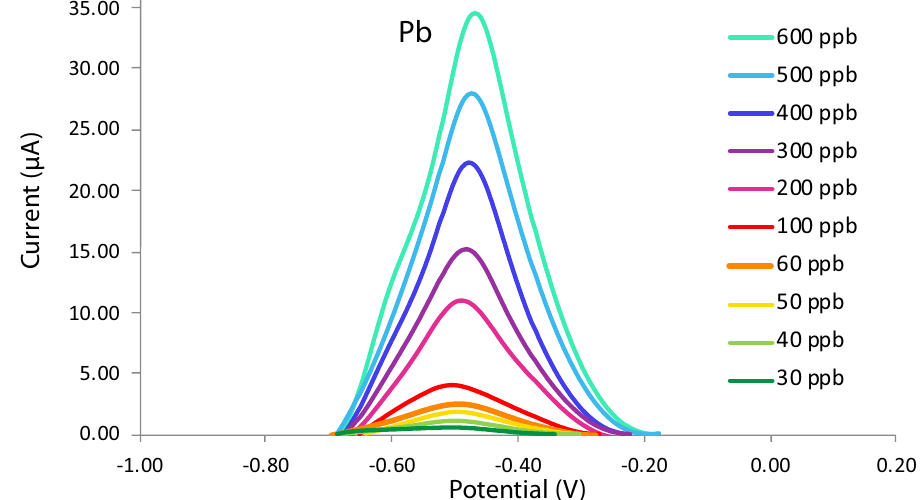
Figure 10. Voltammograms for varying Pb concentrations.